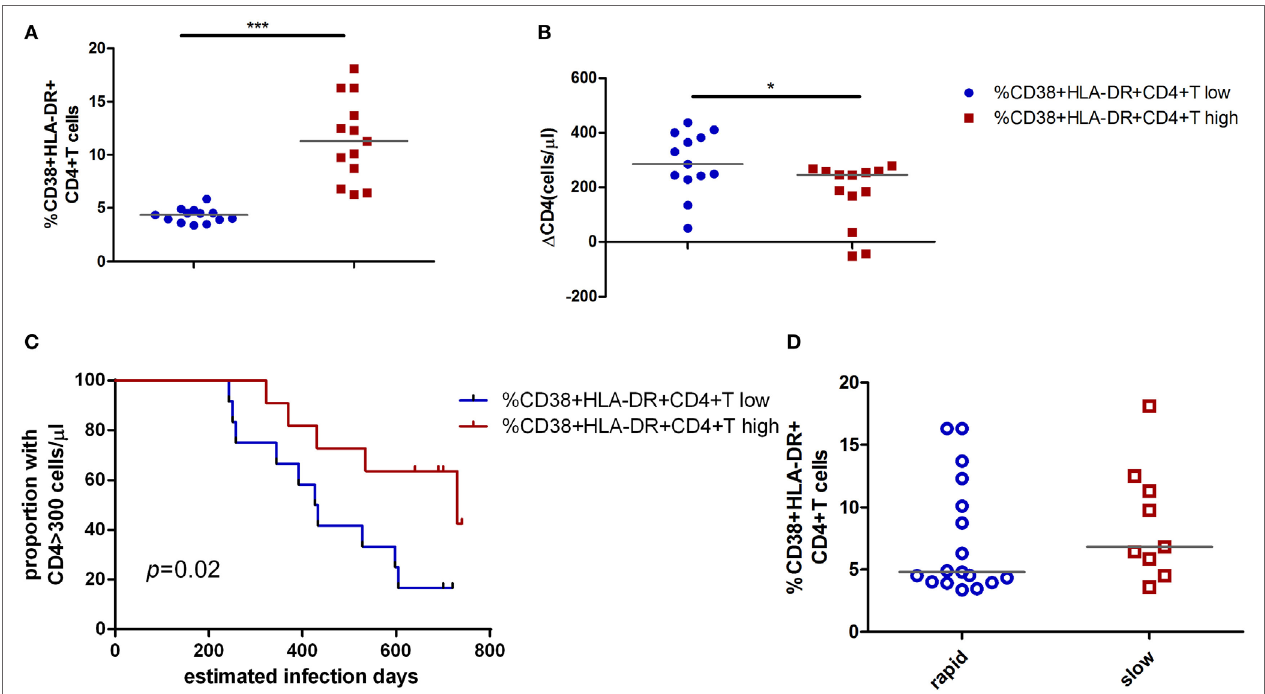
FigUre 2 | Impact of CD4 + T cell activation in acute HIV-1 infection on clinical outcomes. Comparison of the level of CD4 + T cell activation (a) and Δ CD4 (b) between CD4 + T cell activation high ( ■ ) and low ( ● ) groups in acute infection stage. (c) Kaplan–Meier curves with univariate analyzes (log-rank) were performed to evaluate the effects of CD4 + T cell immune activation during acute HIV-1 infection stage on CD4 + T cell depletion. Endpoints were defined as CD4 + T cell count < 300 cells/ μ l. Blue line, low CD4 + T cell activation; red line, high CD4 + T cell activation. (D) Comparison of the level of CD4 + T cell activation between rapid ( ○ ) and slow ( □ ) progressors. Rapid progressors: CD4 + T cells drop to less than 300 cells/ μ l in 2 years after acute infection. Slow progressors: CD4 + T cells maintain to more than 500 cells/ μ l in 2 years after acute infection. Significance of difference was calculated by Mann–Whitney U test. Horizontal lines indicate median values (* p < 0.05, ** p < 0.01, *** p < 0.001).